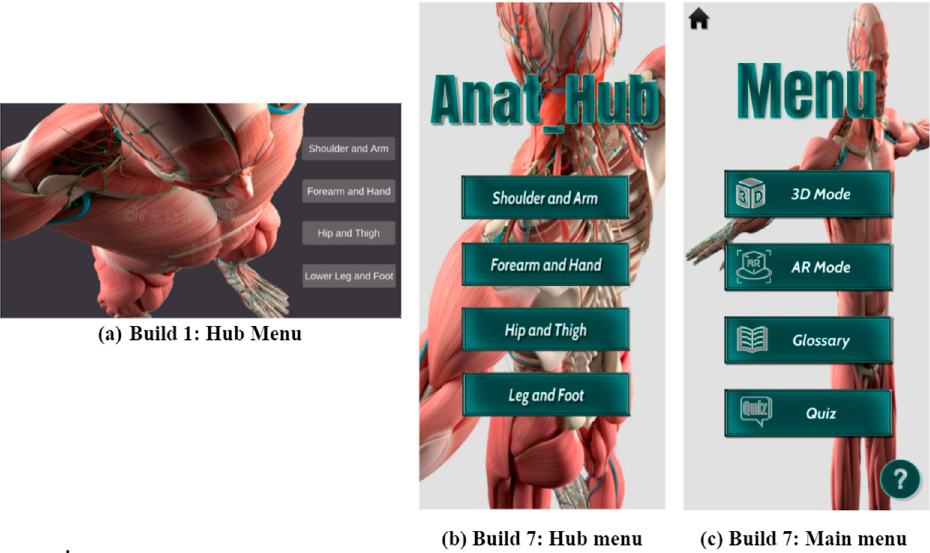
Figure 3. The changes made to the Hub and Main Menu, including final UI design and placement, during application development.